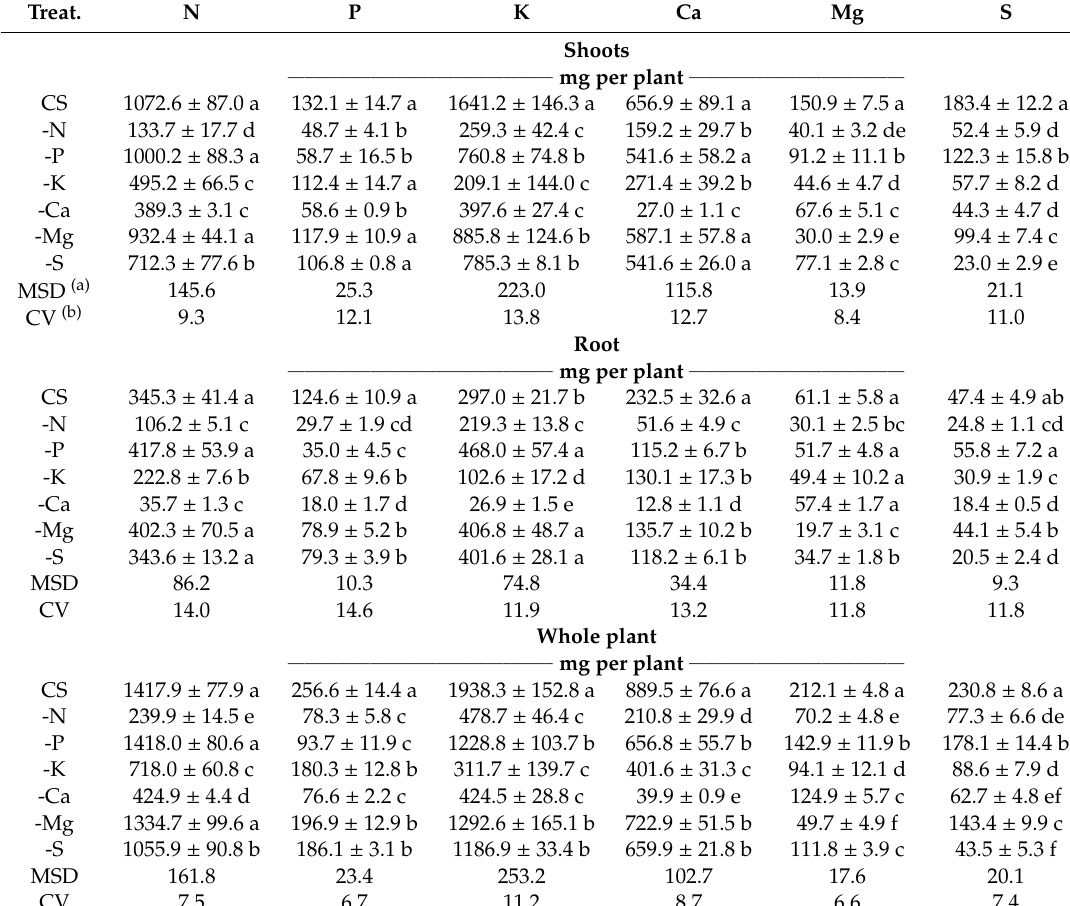
Table 4. Nutrient accumulation in shoots, roots and whole broccoli ( Brassica oleracea var. italica L.) plants cultivated with a complete nutrient solution (CS) and with the omission of macronutrients.